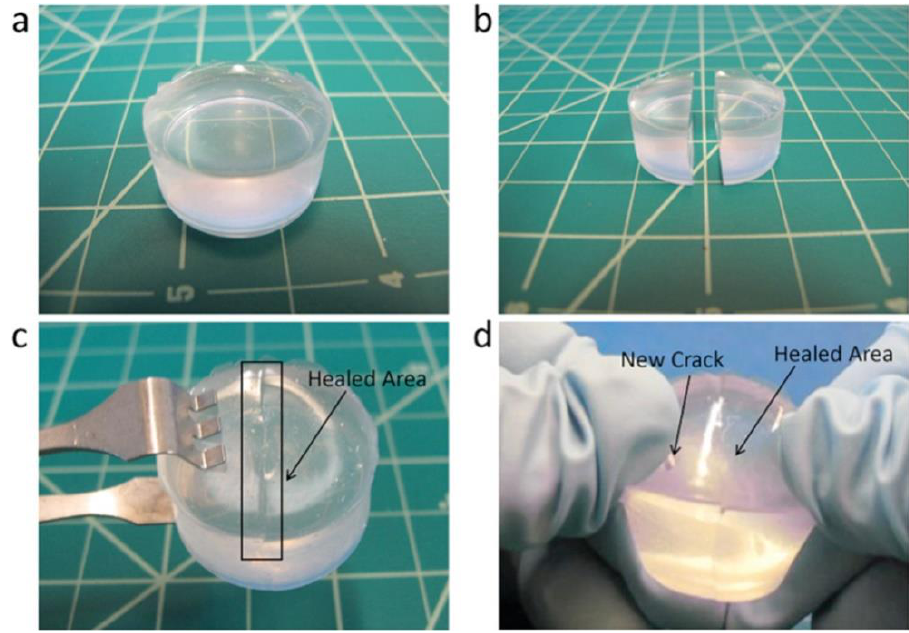
Figure 4. Optical images of ( a ) a cylindrical PDMS sample, ( b ) the sample was cut in half with a razor blade, ( c ) after healing at 90 °C for 24 h, and ( d ) deformation of the healed cylinder showing crack occurring at a different place than the healed area [24]. Reprinted with permission from Ref. [24]. Copyright 2012 American Chemical Society.